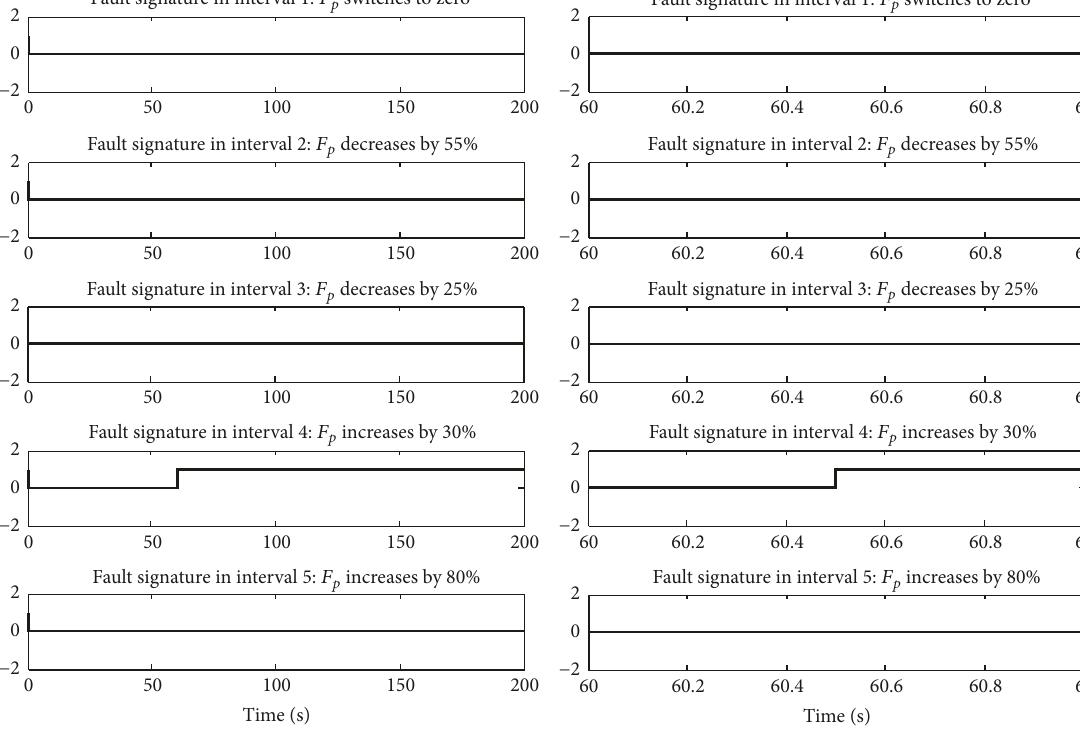
Figure 17: Fault signature sent by parameter filters of process fluid 𝐹 𝑝